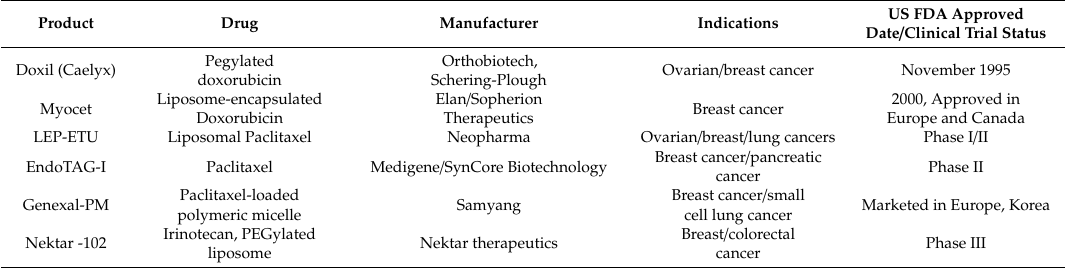
Table 8. List of liposome-based drug products approved by the US FDA and under clinical investigation.